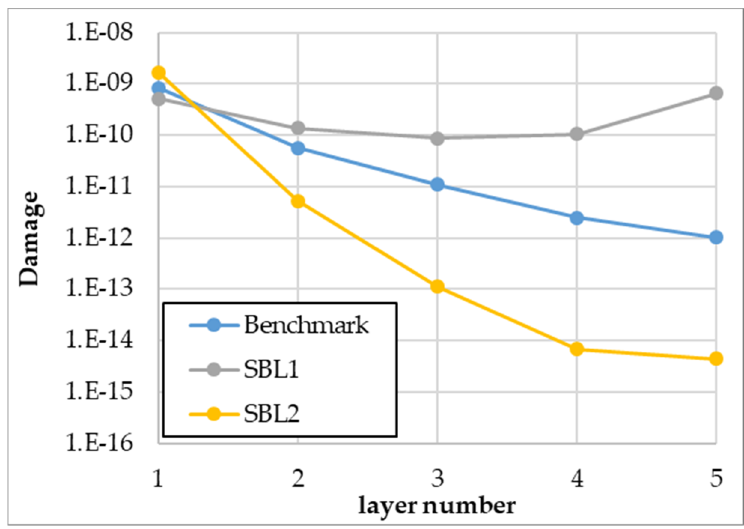
Figure 15. The damage at beginning of bonding line.